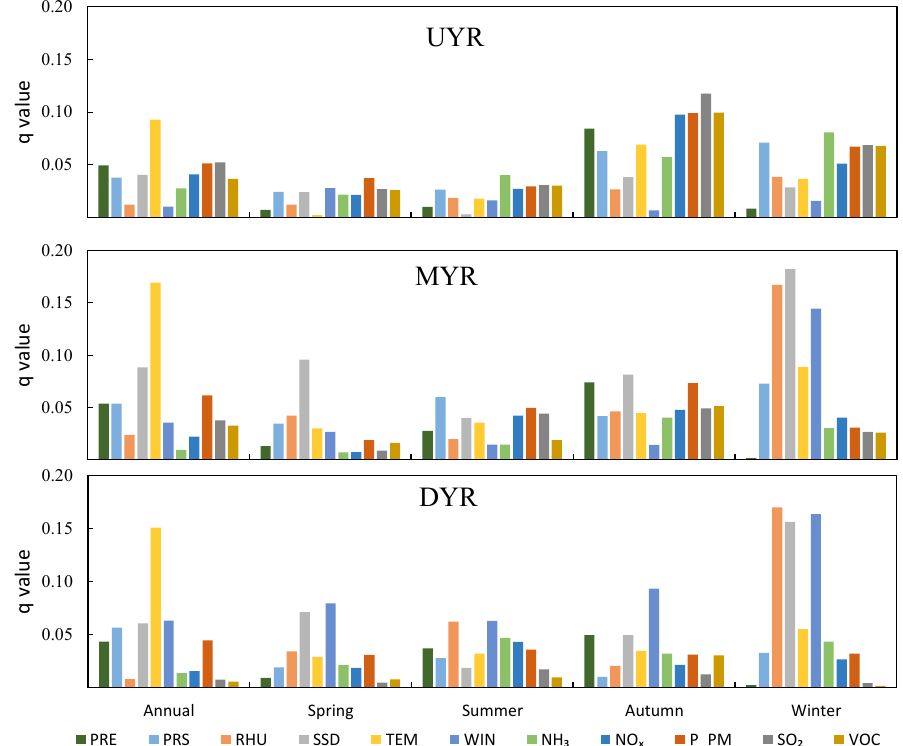
Figure 6. The inter-annual and inter-season q -values of the driving factors on PM2.5 concentrations in the sub-basin of the Yellow River Basin. (UYR denotes the Upper Yellow River Basin; MYR, denotes the Middle Yellow River Basin; DYR, denotes the downstream area of the Yellow River Basin; PRE denotes accumulated precipitation; PRS denotes surface air pressure; RHU denotes 2-m relative humidity; SSD denotes sunshine duration; TEM denotes air temperature; WIN denotes 10-m wind velocity; NH 3 denotes ammonia; NOx denotes nitrogen oxides; P_PM denotes primary PM2.5; SO 2 denotes sulfur dioxide; VOC denotes volatile organic compounds.)